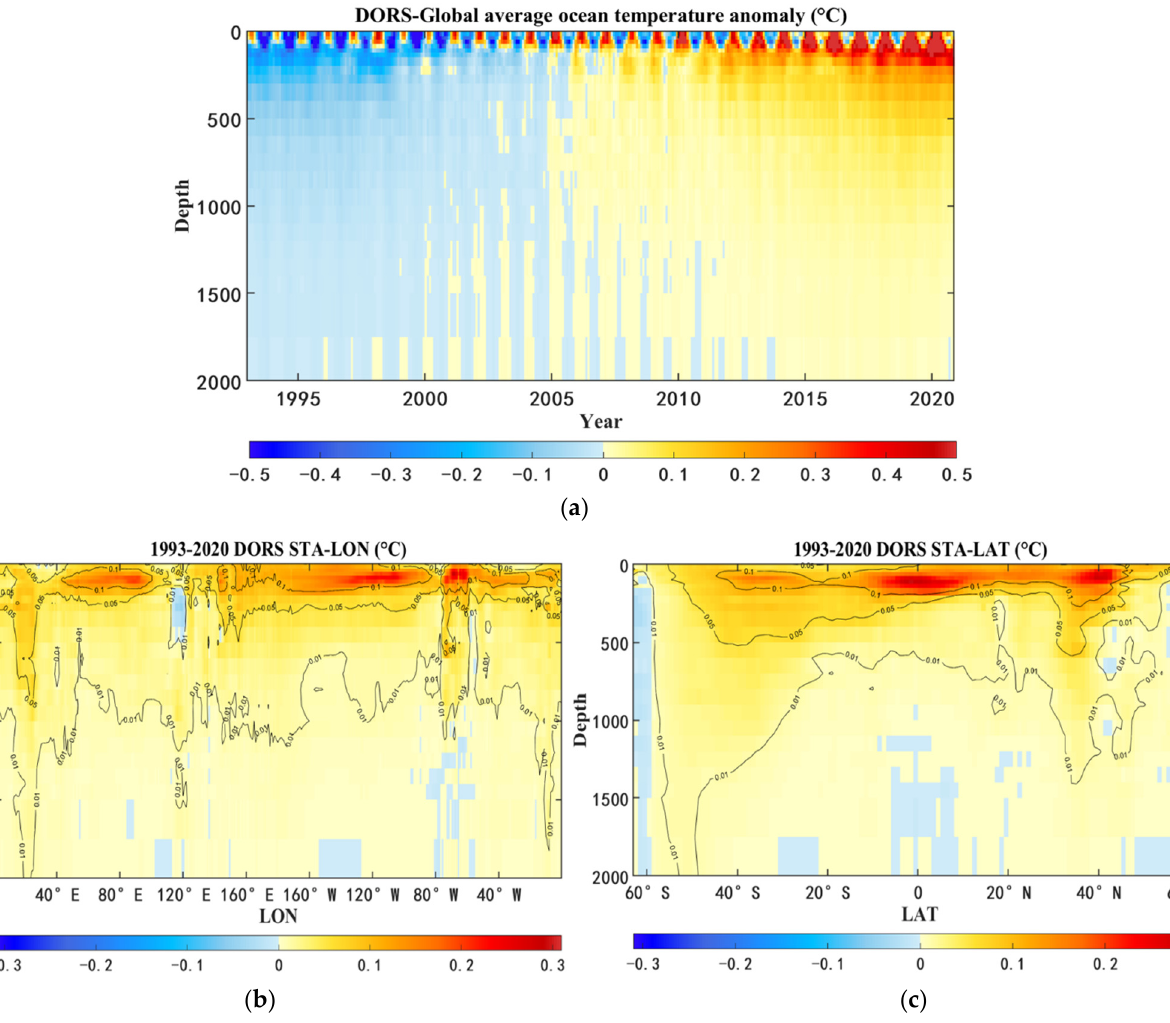
Figure 15. ( a ) Long-term change in the global ocean temperature vertical profile. ( b ) Long-term meridional profile change in global ocean temperature. ( c ) Long-term zonal profile change in global ocean temperature.